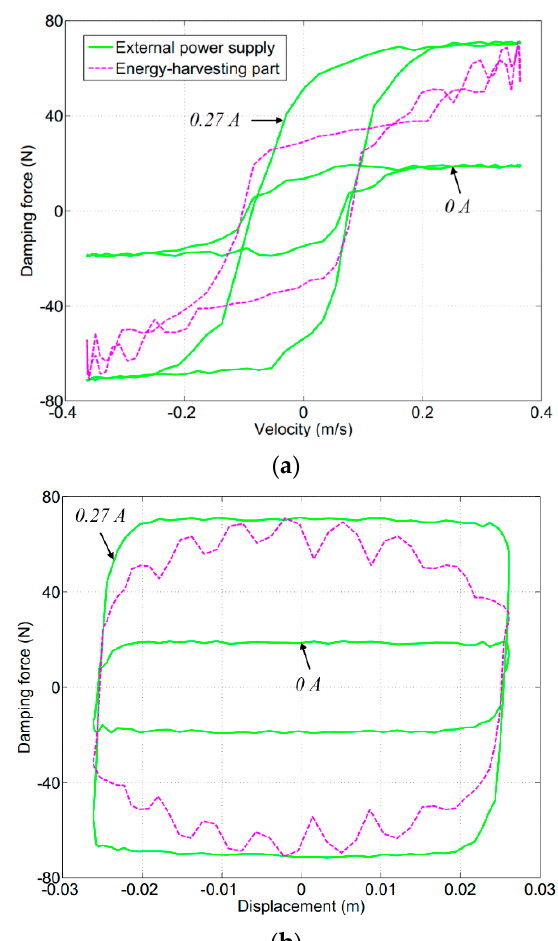
Figure 18. Experimental results of the MR damper with the EH part and under constant external currents in the case when the excitation is 2.2 Hz frequency and 26 mm amplitude: ( a ) force vs. velocity and ( b ) force vs. displacement.